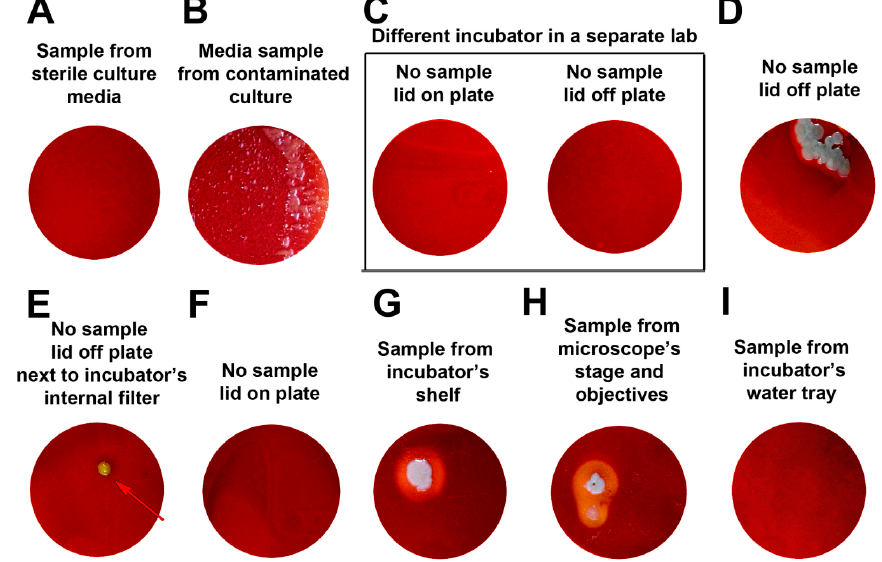
Figure 1. Representative microscopy images of cells. ( A ) shows a contaminated culture, ( B , C ) show clean and appropriate cell culture for pancreas and myoblast cells, respectively. Images were captured using 10 × magnification by Zeiss Axiovert A1.